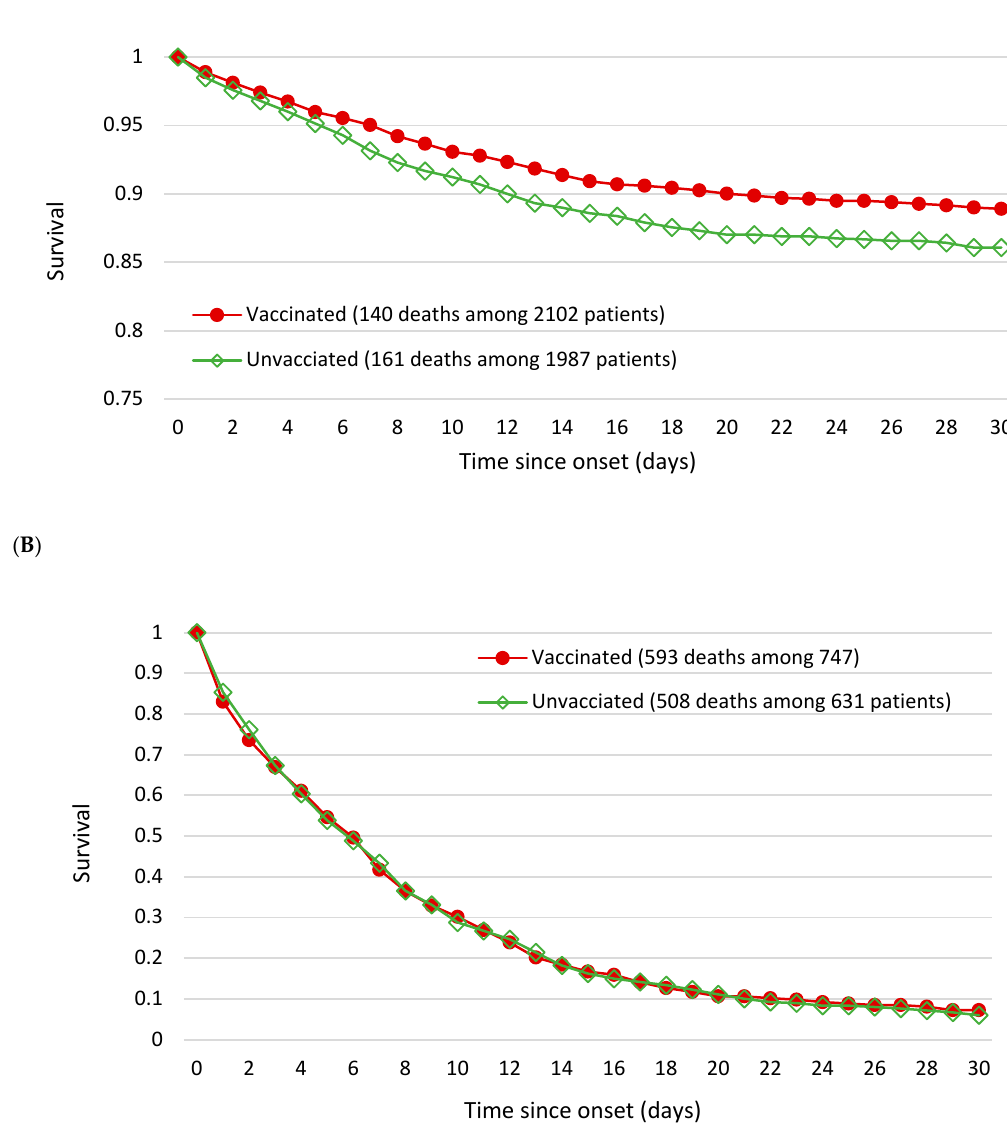
Figure 1. Survival curve of hospitalized patients by vaccine status ( A ) Moderate ( B ) Severe patients. Recall that the entire population in Taiwan had been invited to have a booster vaccina- tion with the mRNA vaccine. This provided an opportunity to assess the pure therapeutic effect of mRNA vaccination. When the booster group was separated from the primary two-dose group among the vaccinated group, the interaction was statistically significant only for the booster (Wald test, χ 2 (1) = 7.4521; p = 0.0063), but not for the primary two-dose group (Wald test, χ 2 (1) = 0.0436; p = 0.8345), suggesting that the preventive effect of mRNA associated with death was modified by the severity of disease. Table 2 also shows the age- adjusted hazard ratio for the booster group (administration of mRNA vaccine) as opposed to the unvaccinated group was 0.71 (95% CI, 0.55 to 0.91) for moderate patients, whereas the corresponding estimate was 1.05 (95% CI, 0.89 to 1.12) for severe patients. As far as